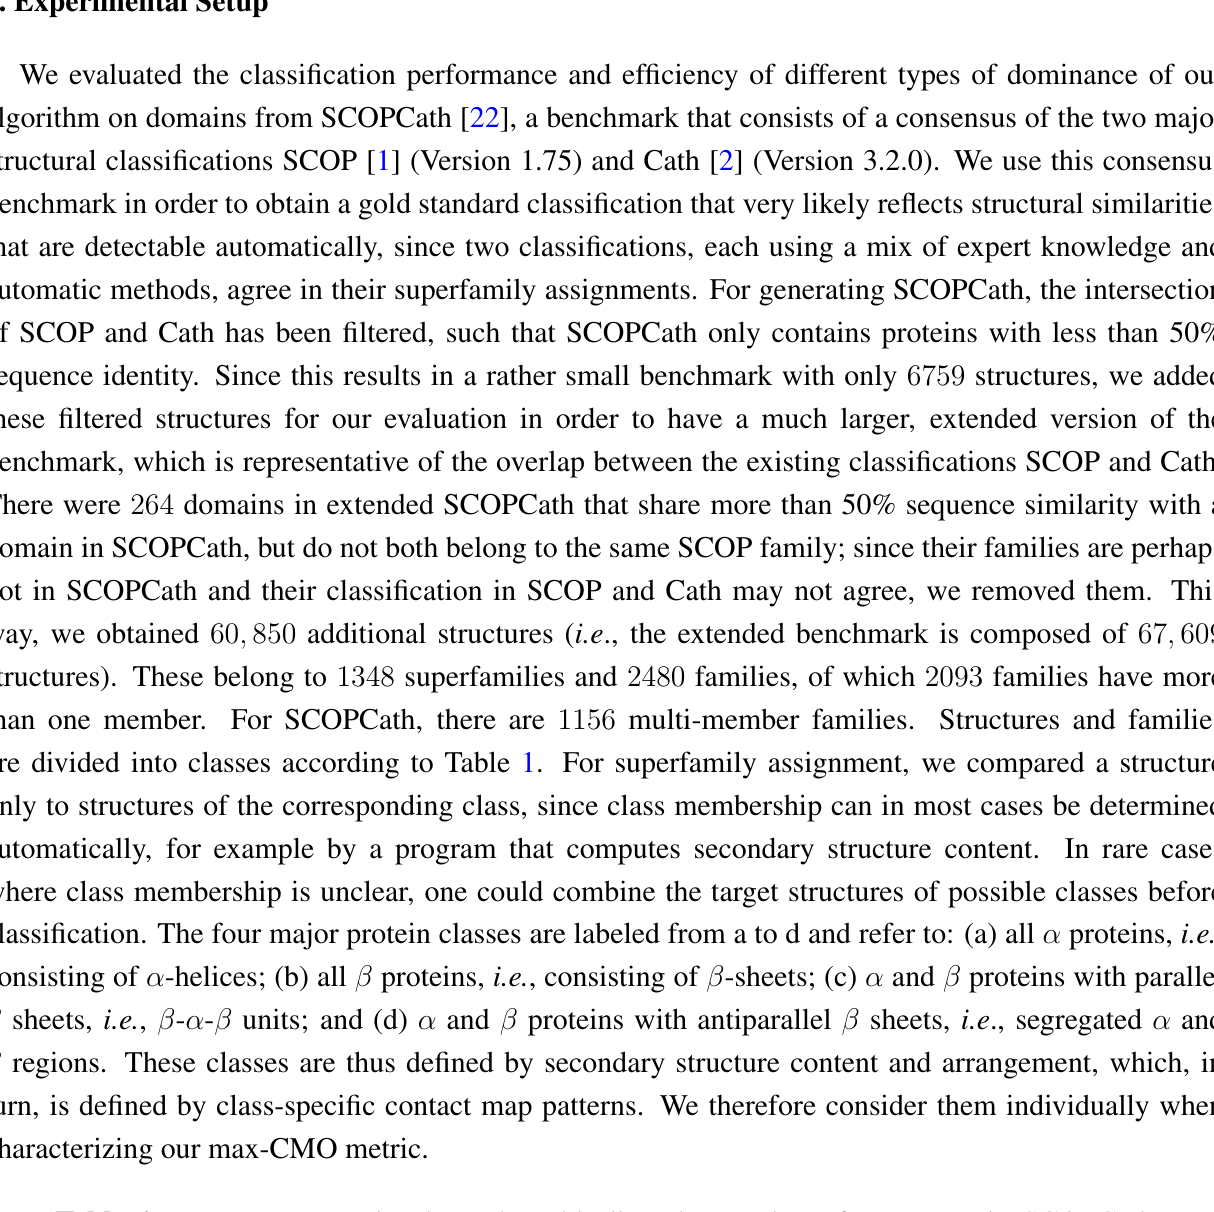
Table 1. For every protein class, the table lists the number of structures in SCOPCath (str) and extended SCOPCath (ext), the corresponding number of families (fam) and superfamilies